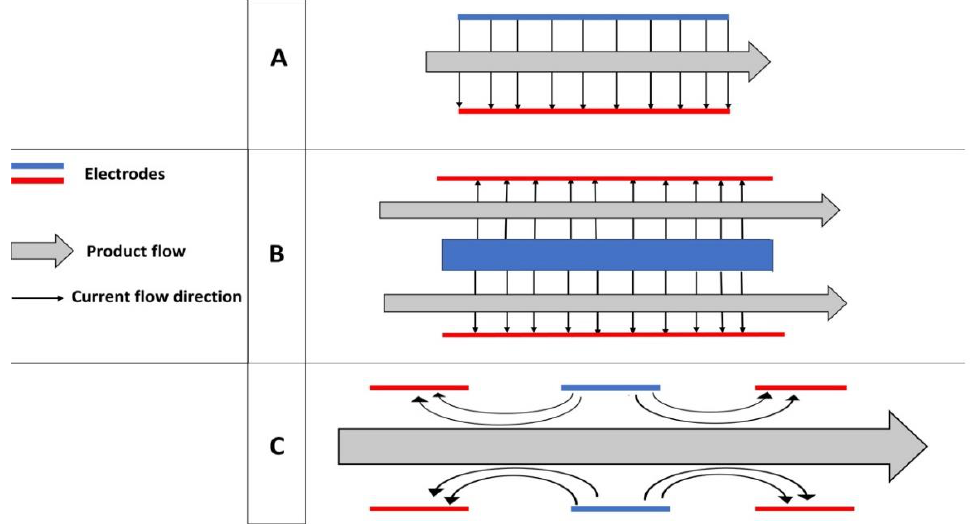
Figure 4. Schematic diagrams of the three main types of treatment chambers in PEF devices. ( A ) parallel plate chambers; ( B ) coaxial plate chambers; ( C ) colinear plate chambers.